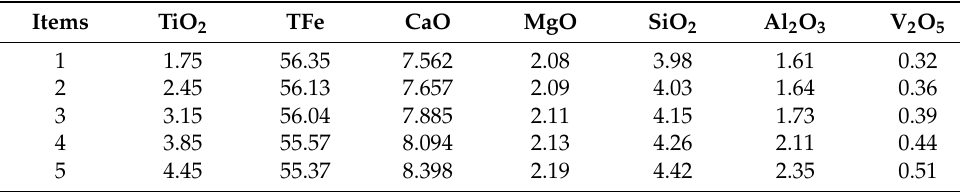
Table 6. Chemical composition of the sinter (wt, %).